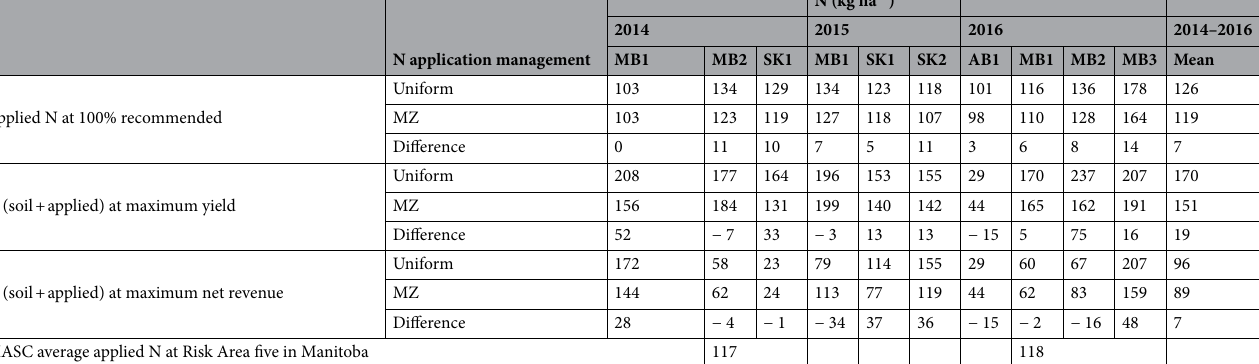
Table 4. Nitrogen (N) at 100% recommended N application and total N rate (soil plus applied) at maximum yield and maximum net revenue for canola production at low, average, and high canola management zones in Manitoba (MB), Saskatchewan (SK) and Alberta (AB), Canada from 2014 to 2016 as well as Manitoba agricultural services corporation (MASC) average applied N at risk area five in Manitoba. Uniform uniform N rate at average canola management zones, MZ average N rate at low, average, and high canola management zones, MASC Manitoba Agricultural Services Corporation 17